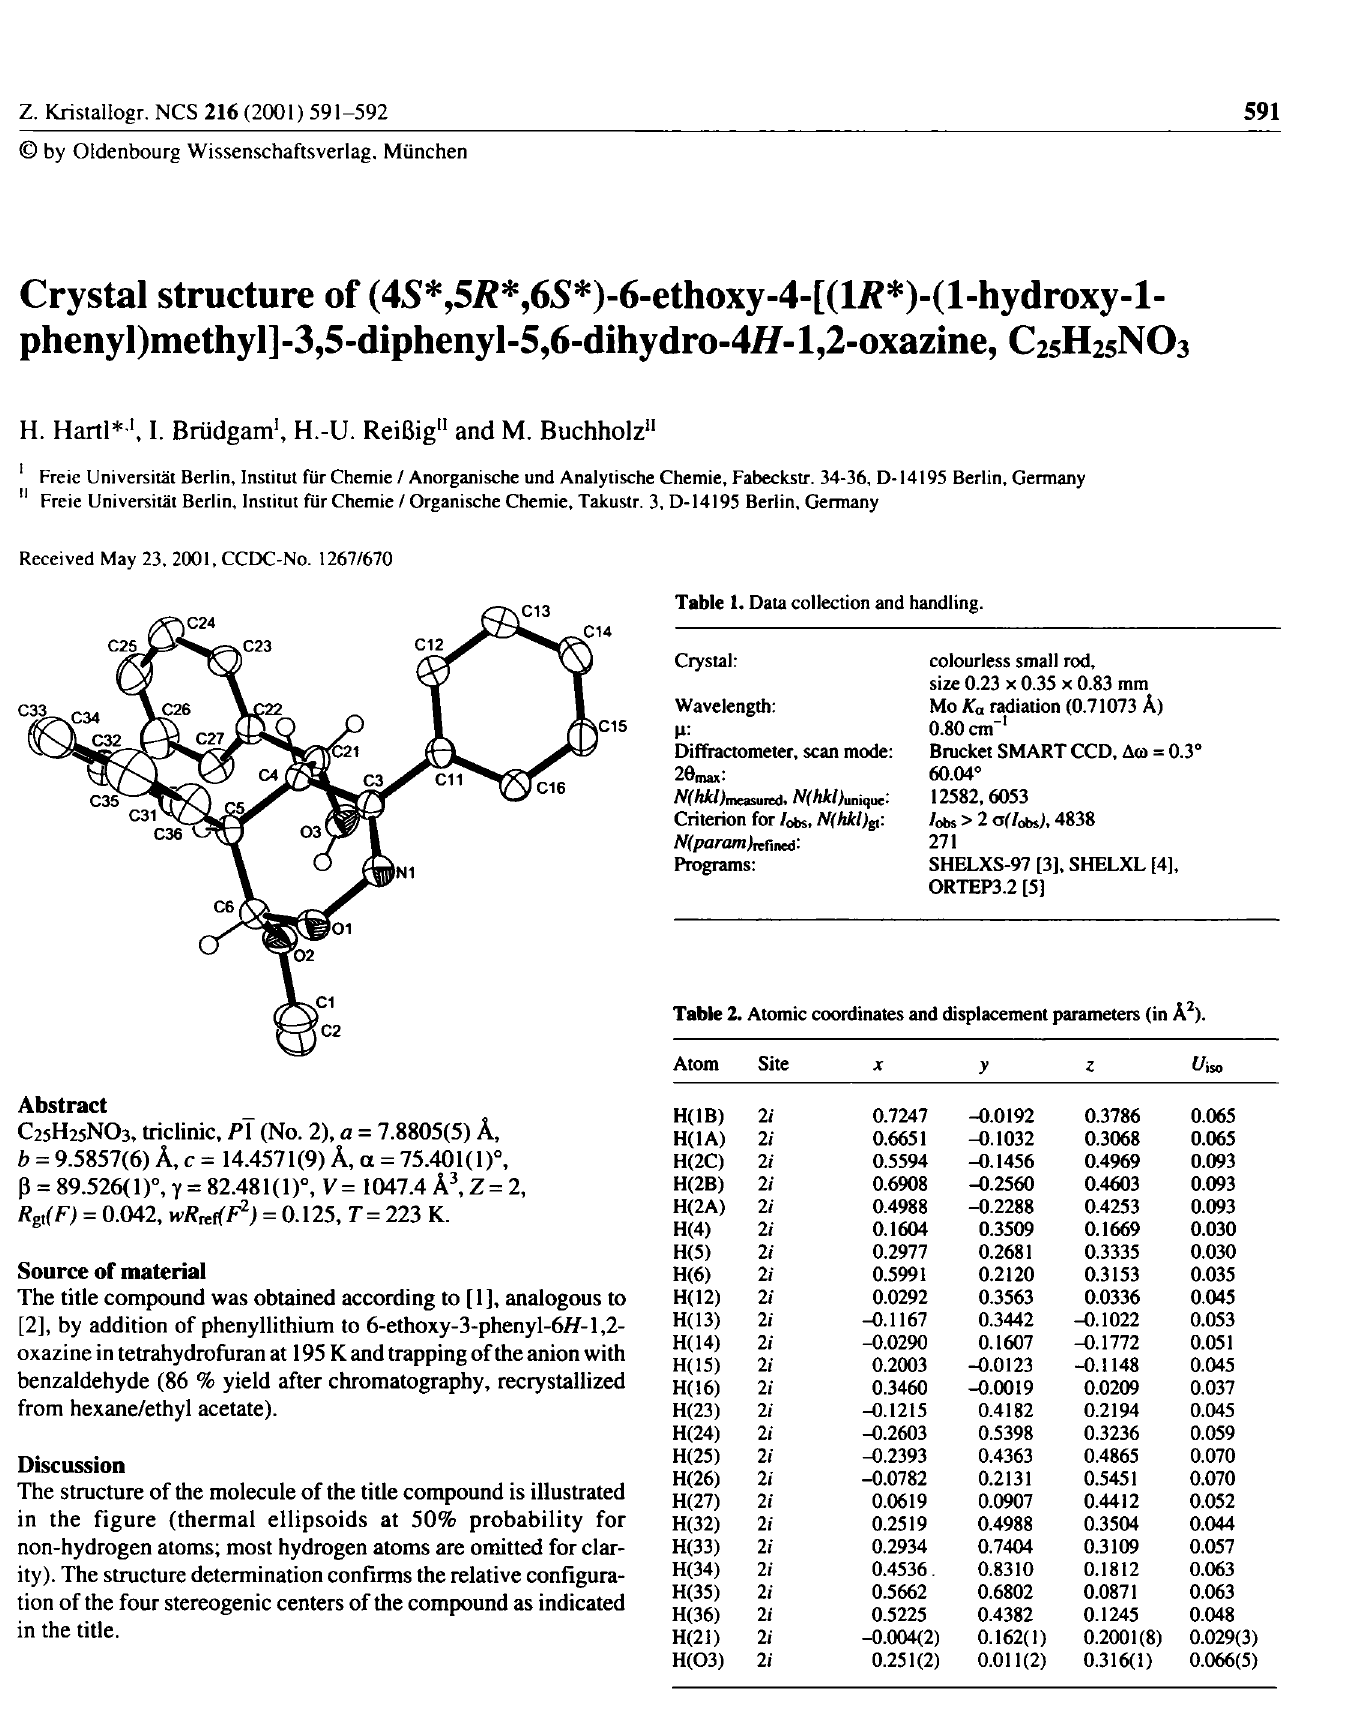
Table 2. Atomic coordinates and displacement parameters (in A 2